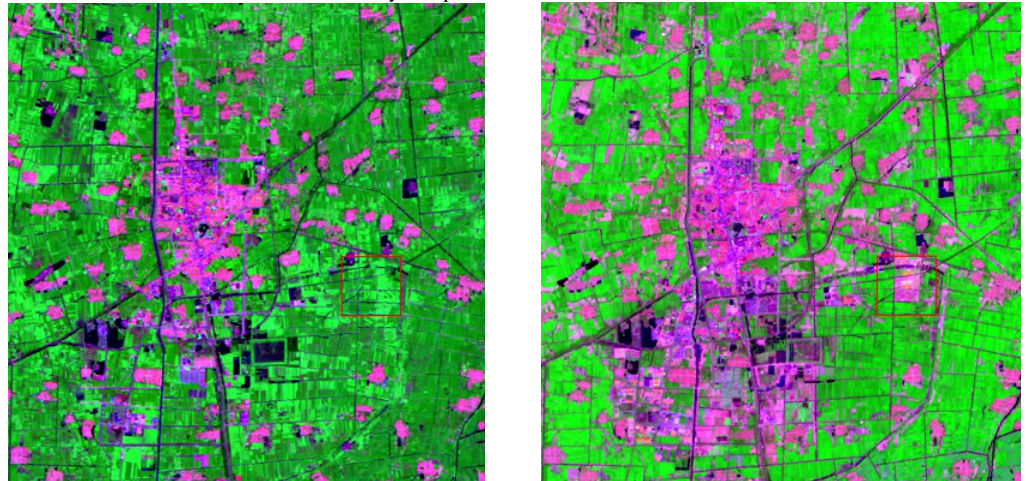
Figure 3. Landsat OLI image of Shandong urban area (band 6, 4 and 2 as R, G and B); left: acquisition in 2010 and right